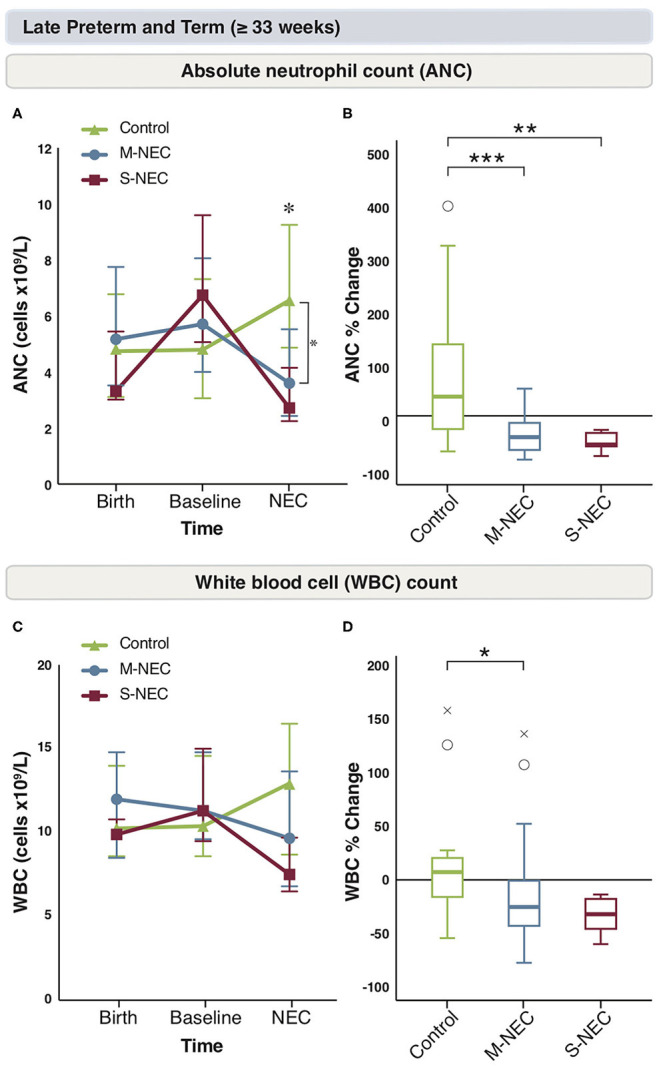
Changes in peripheral cell counts for infants ≥33 weeks. Median absolute levels of neutrophils (A) and WBC count (C) are plotted at birth, baseline, and NEC diagnosis. Tukey boxplots for percent changes in neutrophils (B) and WBC count (D) at NEC diagnosis compared with baseline. Bars represent 25 and 75% percentiles (A,C) or 1.5× the IQR (B,D). *Significance for absolute cell count; *p < 0.05. *Significance for percent change; *p < 0.05, **p < 0.01, ***p < 0.001. °Indicates outliers (>1.5 × IQR) and xindicates extreme outliers (>3 × IQR).